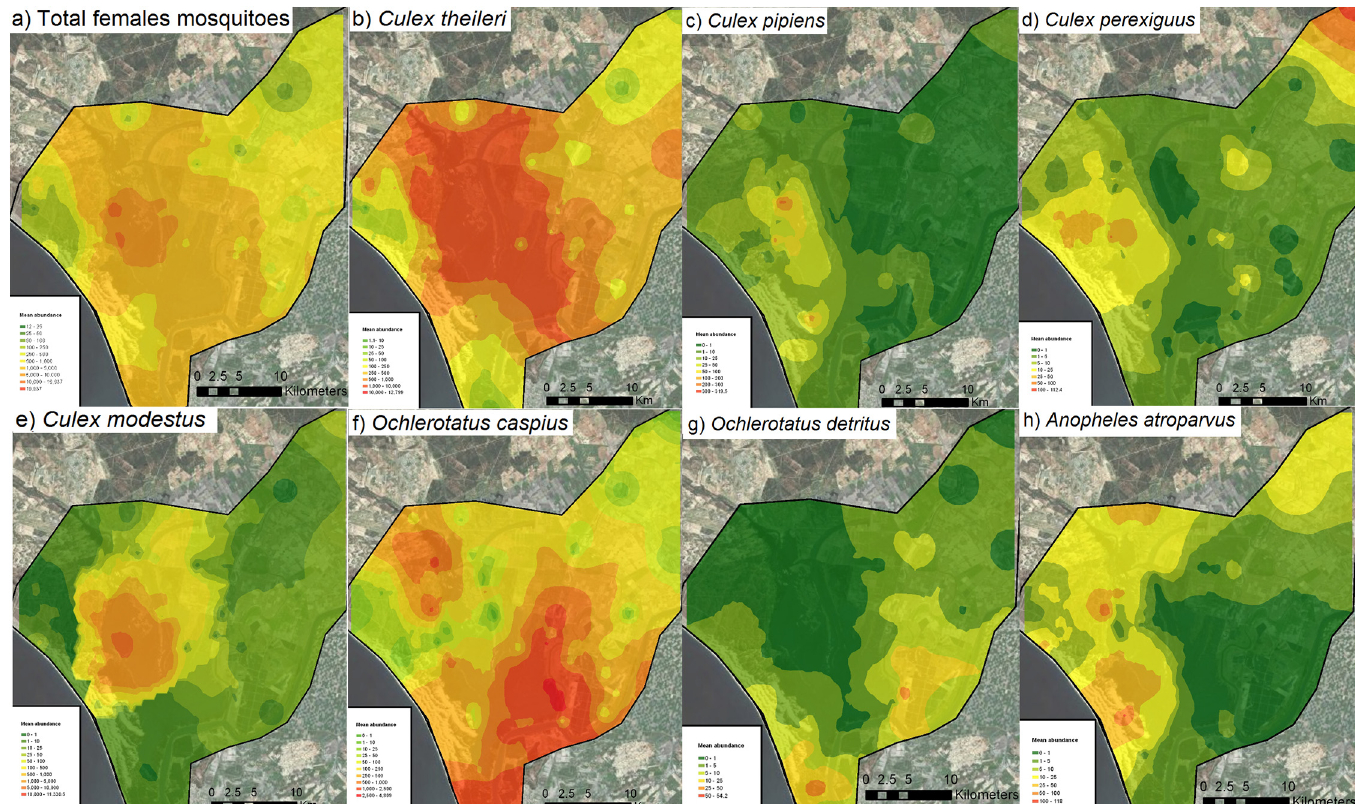
Fig 3. Spatial interpolation by kriging of annual mosquito abundances of: total female mosquitoes (a), Cx . theileri (b), Cx . pipiens (c), Cx . perexiguus (d), Cx . modestus (e), Oc . caspius (f), Oc . detritus (g), and An . atroparvus (h) with an ortophotograph of the area.